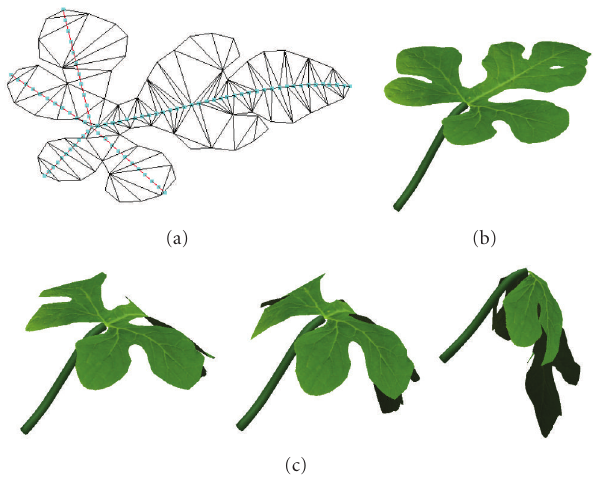
Figure 8: A skeleton structure of watermelon leaf and modeling e ff ects: (a) venation skeleton and mesh, (b) initial leaf shape and (d) three simulated wilting e ff